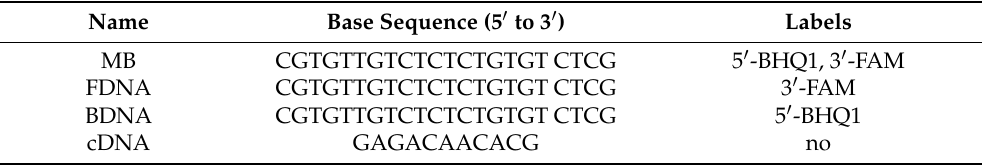
Table 1. Information of different DNA